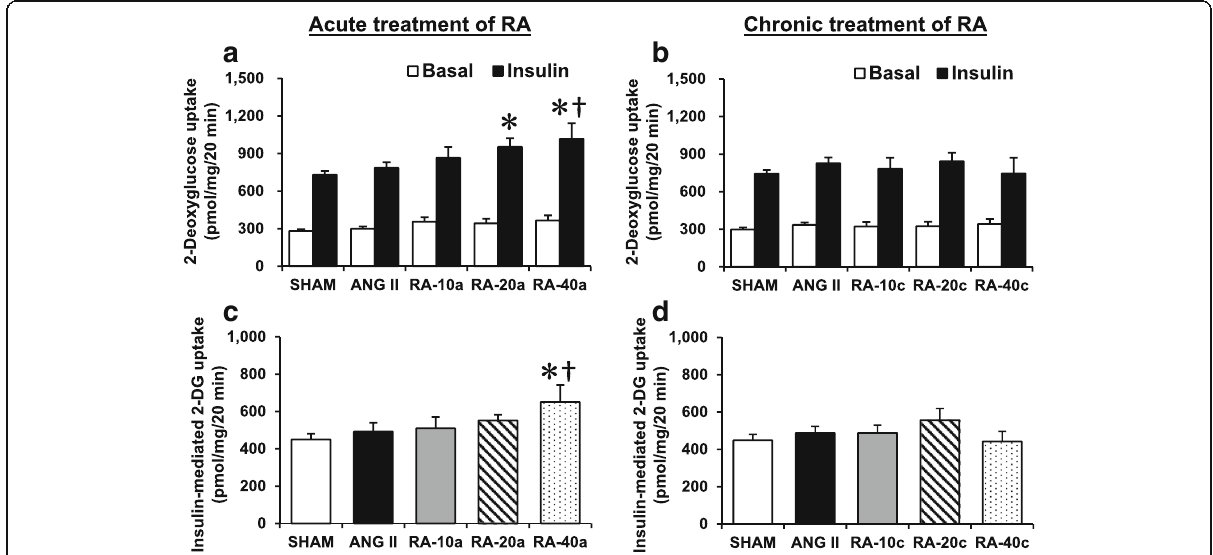
Fig. 2 Glucose transport activity in basal and insulin-stimulated conditions, and differential changes among the basal and insulin-stimulated conditions (insulin-mediated 2-DG uptake) after SHAM, ANG II, acute RA (RA-10a, -20a, and -40a mg/kg) ( a , c ), and chronic RA (RA-10c, -20c, and -40c mg/kg) ( b , d ) treatment. Values are the mean ± SE. * P < 0.05 vs SHAM group; † P < 0.05 vs ANG II